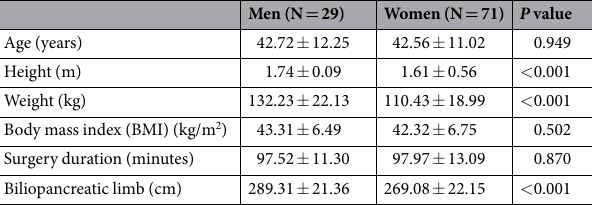
Table 1. General patient